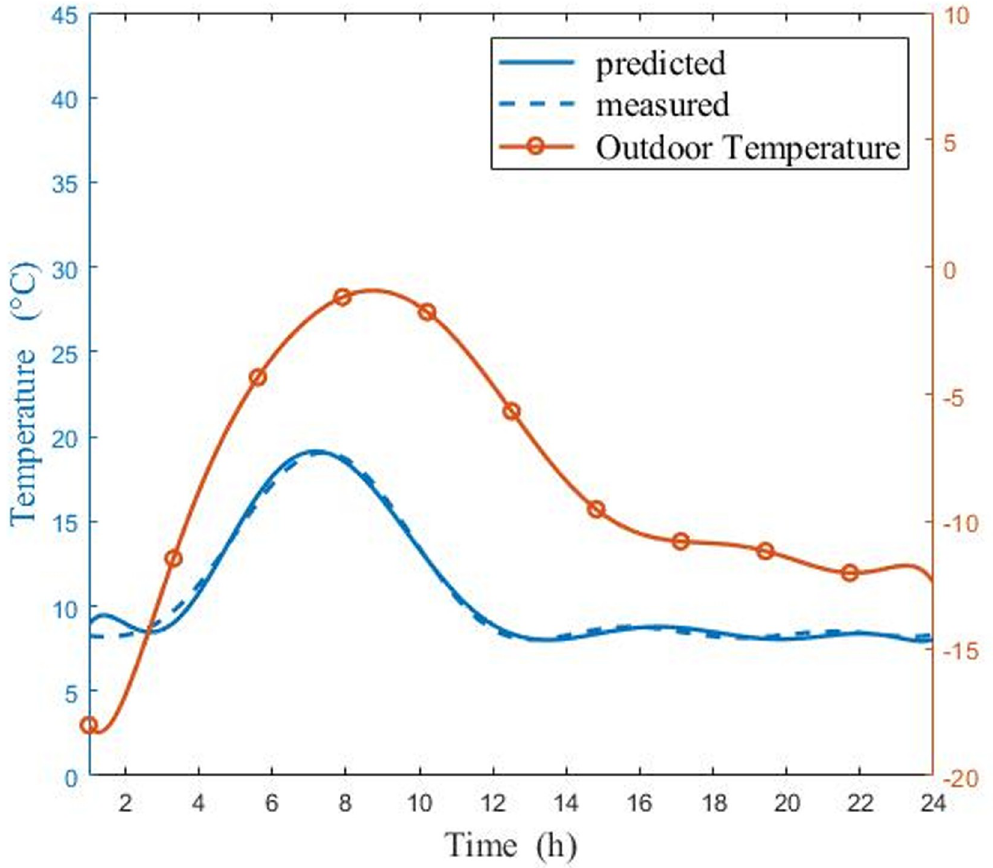
Fig 10. Comparisons of measured and predicted air temperatures in the CSG in cloudy day (6:00 in the morning ~ 5:00 the next day).